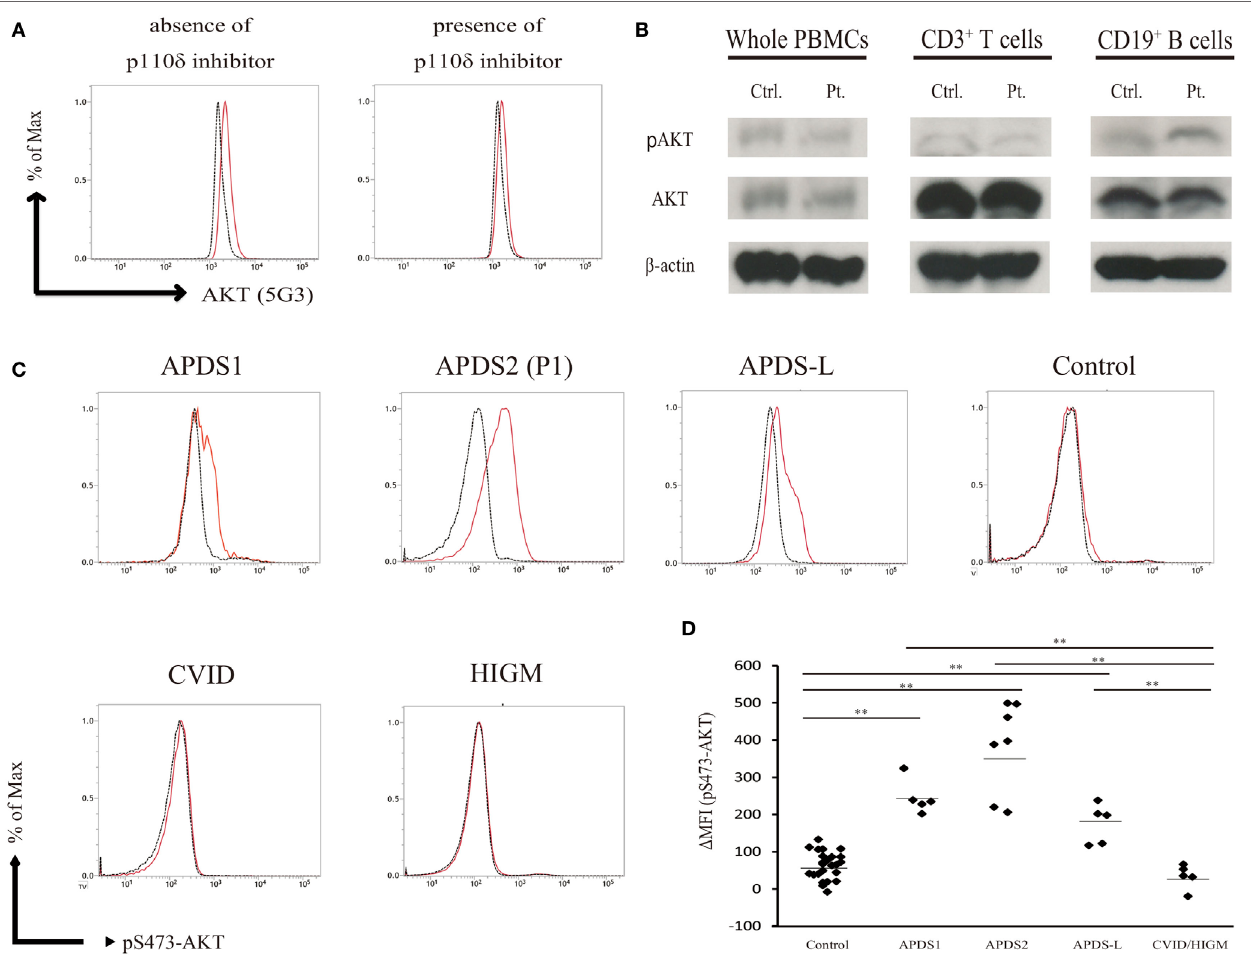
FigUre 3 | Enhanced AKT phosphorylation (pAKT) in CD19 + B cells from patients with activated PI3K δ syndromes (APDSs) or APDS-like (APDS-L). (a) Total AKT expression in CD19 + B cells from APDS2 patients (P1) was measured by flow-cytometry. Red bold line: activated PI3K δ syndrome 2 (APDS2) patient and black dotted line: healthy control. (B) The phosphorylation and protein expression of AKT was investigated by immunoblotting. (c) pAKT (pS473) in the presence of p110 δ inhibitor was analyzed by flow cytometry in CD19 + B cells from healthy controls and patients with APDS1, APDS2, or APDS-L, CVID/HIGM. The number of events analyzed was > 5,000. (D) A summary of difference in mean fluorescence intensity of CD19 + B cells derived from healthy controls or patients with APDS1 (four patients), APDS2 (P1, P2, P3, and P4), APDS-L (four patients), or CVID/HIGM (P5, P6, P7, P8, and P9). * p < 0.05 and ** p <